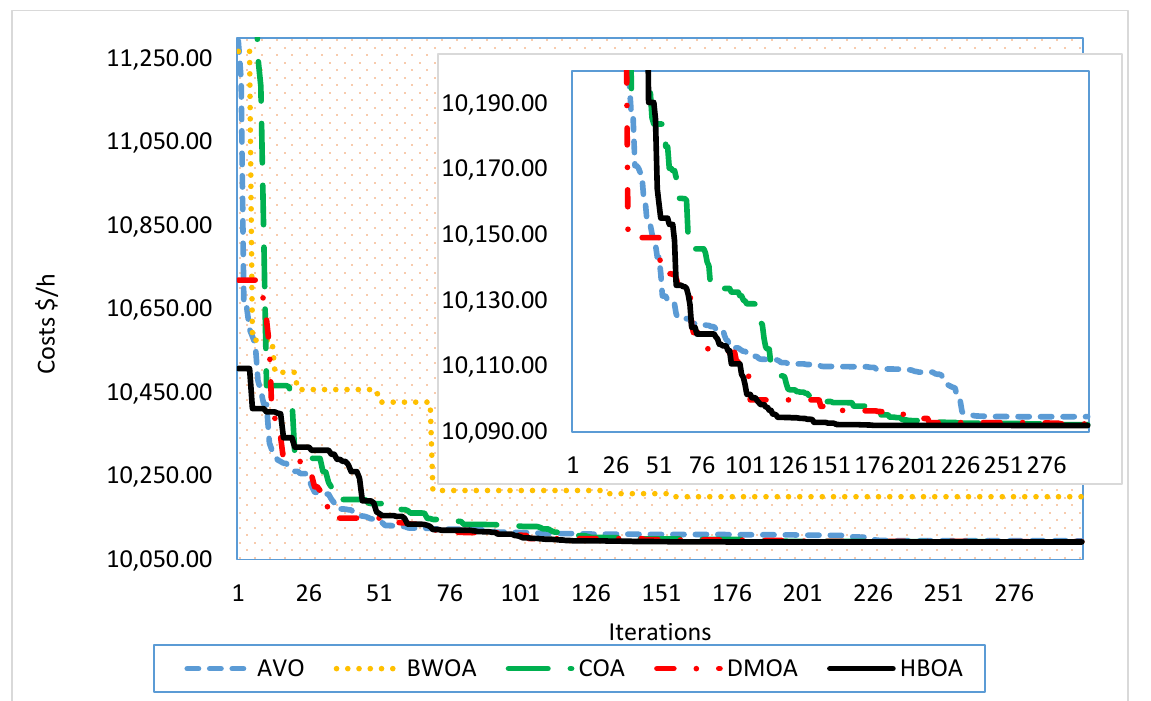
Figure 3. Convergence rates of the proposed HBOA and the AVO, DMOA, COA, and BWOA of Case 1 for the first loading.